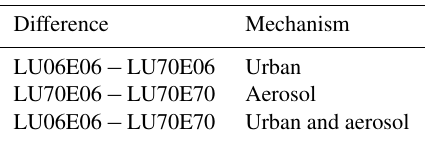
Table 3. Analysis strategies for the investigation of urban land-use and/or aerosol